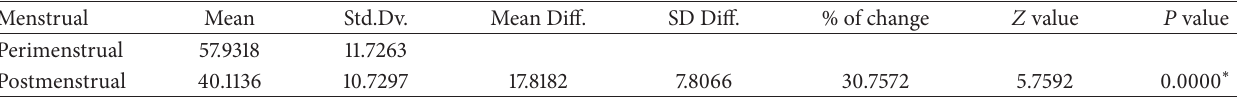
Table 2: Comparison of perimenstrual and postmenstrual VAS scores by Wilcoxon matched pairs test by ranks. Menstrual Mean Std.Dv.